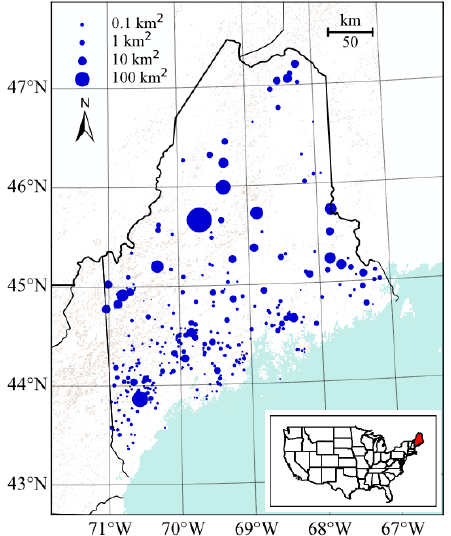
Figure 1. Locations of study lakes in Maine.